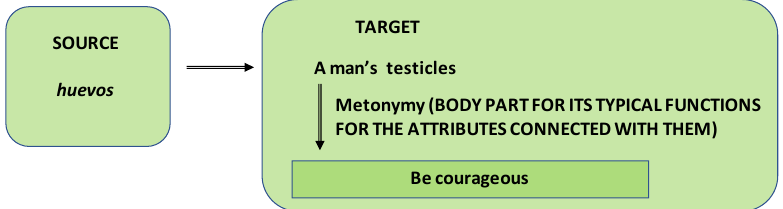
Figure 7. Metonymic reduction of the metaphoric target underlying the interpretation of tener huevos .